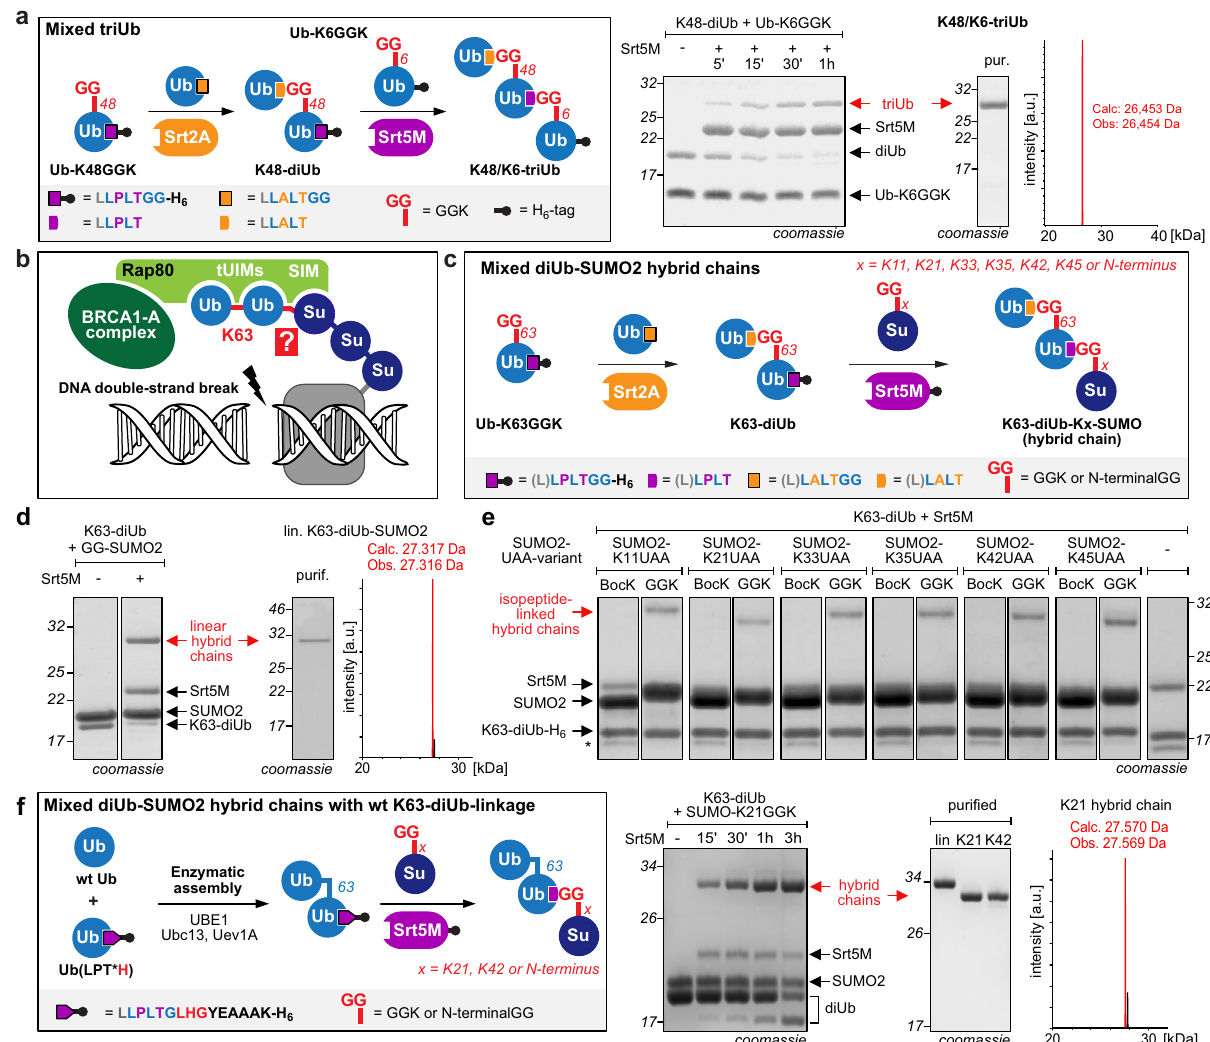
Fig. 3 Ubl-tools mediated access to heterotypically linked Ubl architectures. a Left: Schematic representation of the two-step assembly of a heterotypically linked triUb using Srt2A and Srt5M. Right: Generation of K48/K6-linked triUb. SDS-PAGE shows Srt5M-catalyzed transpeptidation between K48-diUb and Ub-K6GGK resulting in the formation of heterotypically K48/K6-linked triUb (K48/K6-triUb). LC-MS analysis con fi rmed the identity of the K48/K6-triUb. Full gels and densitometric yield determination can be found in Supplementary Fig. 5. b Model for Ub-SUMO2 hybrid chain- mediated recruitment of BRCA1-A complex to double strand breaks (DSBs) through SUMO and Ub modi fi cations of chromatin, presumably H2AX 12 . Rap80 contains a SUMO2-interacting motif (SIM) followed by tandem ubiquitin interacting motifs (tUIMs) with high af fi nity for K63-linked diUb, suggesting the involvement of K63-diUb-SUMO2 hybrid chains. The distinct site of linkage between K63-diUb and SUMO2 is unknown. SUMO2 displays nine possible sites for K63-diUb attachment (the N-terminus and eight lysine residues). c Schematic presentation of the two-step strategy to generate linearly or isopeptide-linked K63-diUb-SUMO2 hybrid chains. Ub-K63GGK bearing the Srt5M motif in its C-terminus (PT/LPT) is reacted with Ub(AT/ LAT) in the presence of Srt2A. The resulting K63-diUb is subjected to Srt5M-transpeptidation with a SUMO2 variant bearing either a N-terminal GG sequence or a site-speci fi cally introduced GGK moiety. d Incubation of Srt2A-generated K63-diUb with a SUMO2 variant bearing a diglycine (GG) moiety at its N-terminus in presence of Srt5M leads to formation of the linear K63-diUb-SUMO2 hybrid chain. LC-MS con fi rms the integrity of the linearly linked hybrid chain. Densitometric analysis revealed linear hybrid chain formation with 78% yield. e SDS-PAGE analysis of Srt5M-mediated transpeptidation of K63-diUb with SUMO2 variants shows speci fi city for SUMO2-GGK variants. BocK-bearing SUMO2 variants do not yield the respective K63-diUb-SUMO2 hybrid chains. Incubation of K63-diUb and Srt5M in the absence of SUMO2-GGK leads to hydrolysis of the Srt5M recognition motif and hydrolysis of the H 6 -tag (depicted by asterisk (*)). UAA stands for unnatural amino acids BocK or GGK. Full gels and densitometrically determined yields as well as LC-MS analysis can be found in Supplementary Fig. 6 and 7a. f Left: Schematic presentation of the two-step strategy to generate K63-diUb-SUMO2 hybrid chains combining enzymatic assembly and sortylation. Enzymatic assembly using Ubc13/Uev1A gives access to K63-diUb bearing the LPT*H motif at the C-terminus of the proximal Ub. Srt5M-mediated transpeptidation with a SUMO2 variant bearing either a N-terminal GG sequence or a site-speci fi cally introduced GGK moiety results in formation of diUb-SUMO2 hybrid chains with wt linkage between the Ub moieties. Right: SDS-PAGE analysis of Srt5M- mediated transpeptidation of wt K63-diUb with SUMO2 variants as well as SDS-PAGE and LC-MS analysis of the puri fi ed hybrid chains. Full gels and densitometric yield determination can be found in Supplementary Fig. 7c. Consistent results were obtained over at least three replicate experiments. Source data are provided as a Source Data fi